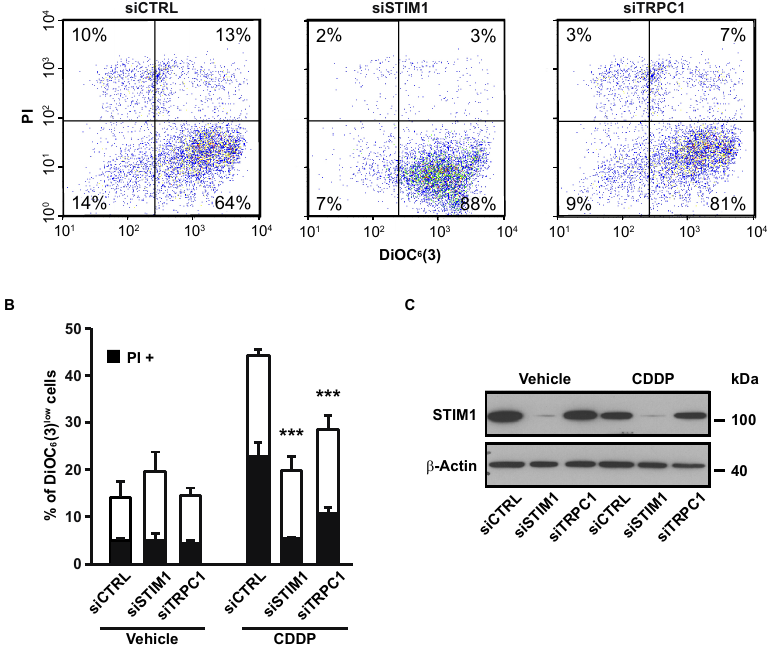
Figure 2. Effects of STIM1 and TRPC1 depletion on apoptosis-associated mitochondrial transmembrane potential (ΔΨ m ) dissipation and plasma membrane permeabilization. ( A )